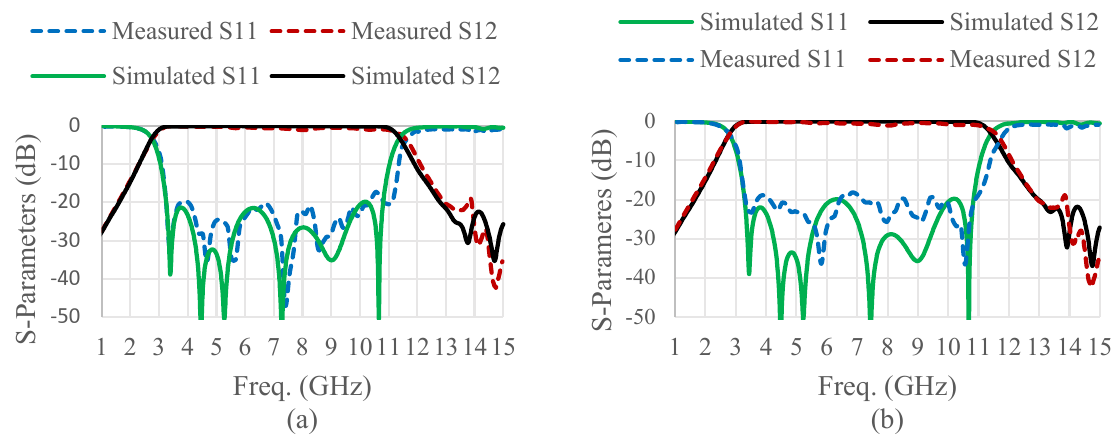
Figure 9. Simulated and measured S-parameters of the proposed UWB filters (represented in Figure 6). ( a ) ETTL of k / β 0 = 0.25. ( b ) Equivalent LTTL. Furthermore, the simulated and measured results of k / β 0 = 0.375 filters with ETTL and LTTL are shown in Figure 10a,b, respectively. Here, the measured return loss is better than 17.3 dB over the bandwidth extended from 3.11 GHz to 10.95 GHz (the fractional bandwidth of 111.52%) and the insertion loss is better than 1 dB over the entire bandwidth for both tapered stubs.